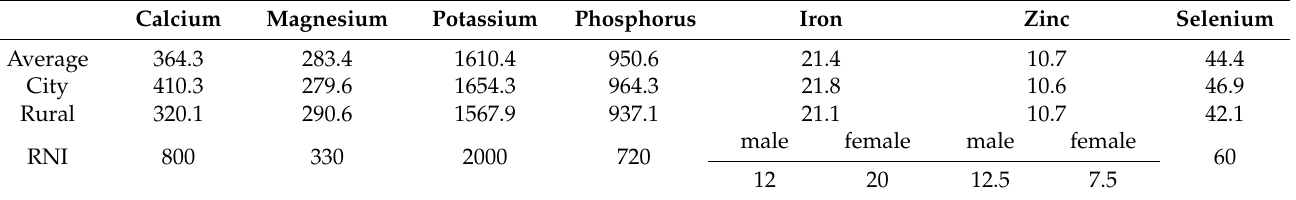
Table 2. The mineral intake of urban and rural residents in China from 2010 to 2013 (mg/d). The selenium intake is expressed in µ g, while the recommended potassium intake value is expressed as